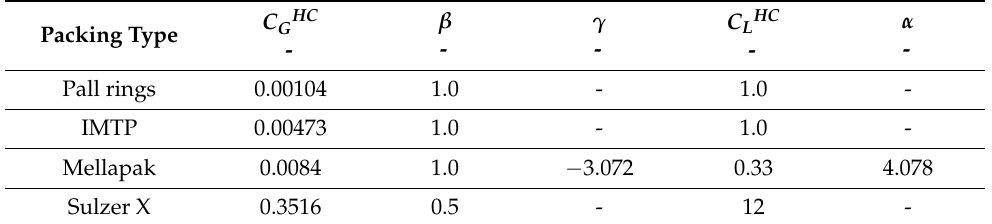
Table 7. Liquid-side and gas-side characteristic parameters in the HC model for different metal packings